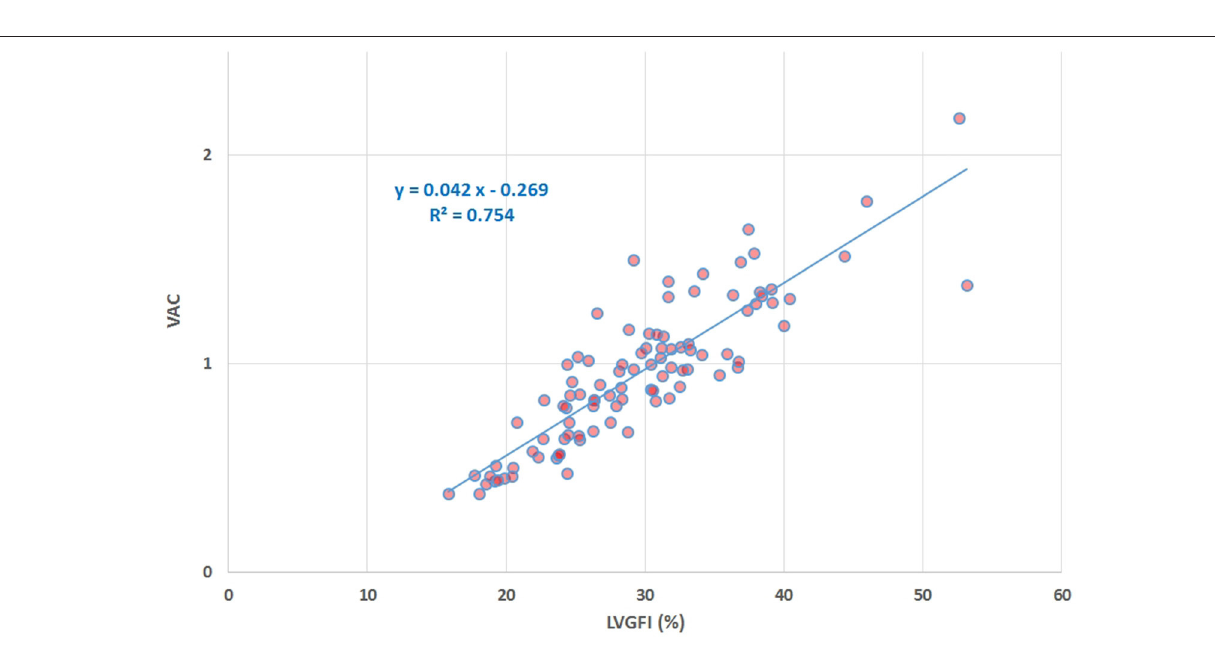
FIGURE 5 | Scatter plot of VAC vs. LVGFI (%), yielding R 0.87. The high correlation clearly demonstrates that the new metric LVGFI and the traditional VAC = (assuming the intercept Vo of the systolic elastance vanishes) are more or less equivalent, mainly due to the fact that they share the same components in their mathematical